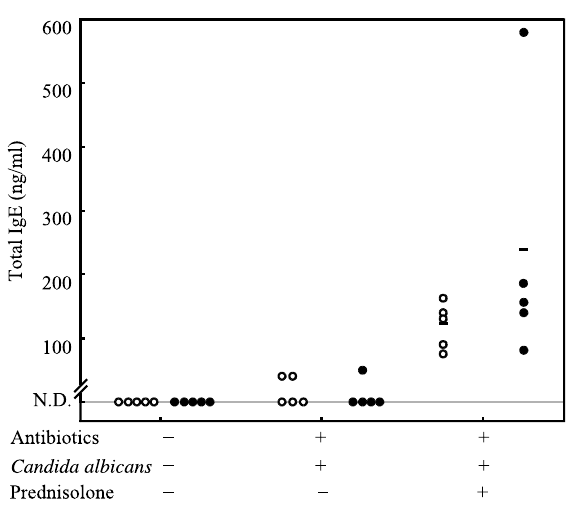
FIG. 3. Total serum IgE levels in C. albicans-infected mice treated with prednisolone. Serum levels were tested at 2 weeks (open circles) and 4 weeks (closed circles) after the Candidainfections. Total IgE were measured using a specific ELISA as described in Materials and methods. Detection limits of total IgE were 40 ng/ml. *p B / 0.05, when compared with the control (normal mouse serum).